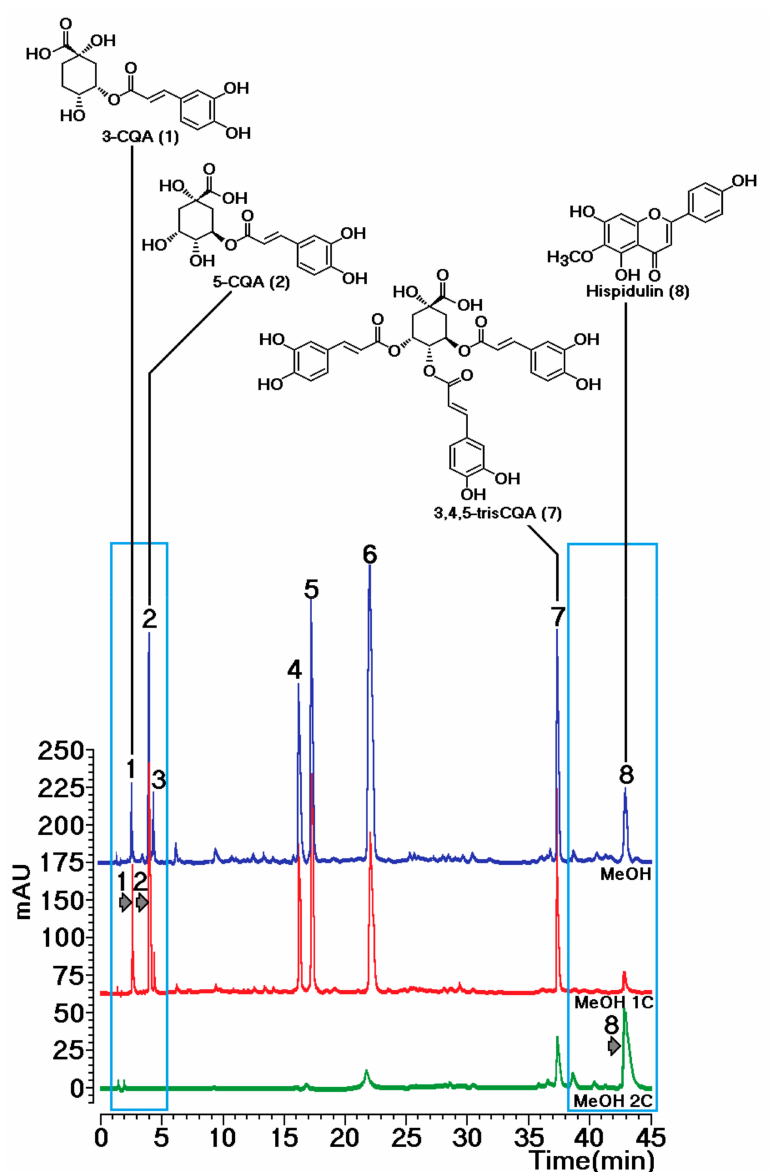
Figure 4. Overlap of chromatograms from samples of methanol crude extract and MeOH 1C and MeOH 2C fractions obtained through the sPLA2 protein–ligand approach. Compounds were identified through NMR analysis as previously described [12,13]: (1) 3-CQA, 3-ca ff eoylquinic